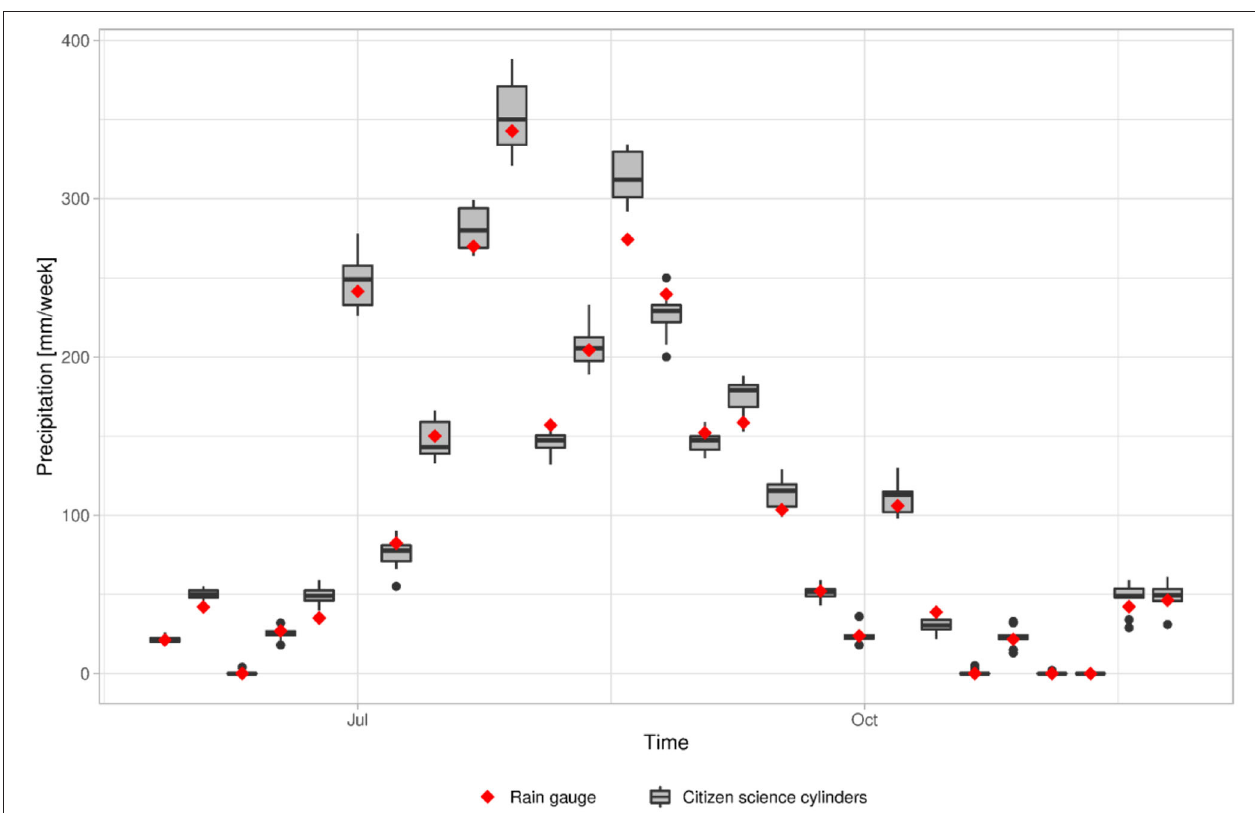
FIGURE 4 | Weekly rainfall totals in 2019 Monsoon season (May–December) for Saraswati Secondary School, Bajura district. Red diamonds = automatic tipping-bucket rain gauge data; gray boxplots = weekly totals of the cylinder data recorded by 10–14 students. Black dots = values that fall outside the whiskers, which represent 1.5 times the interquartile range. The mean of the absolute difference between the average of all cylinders reading in a week, and the corresponding rain gauge reading, is 6.7mm week − 1 (minimum = 0mm week − 1 ; maximum = 38.7mm week − 1